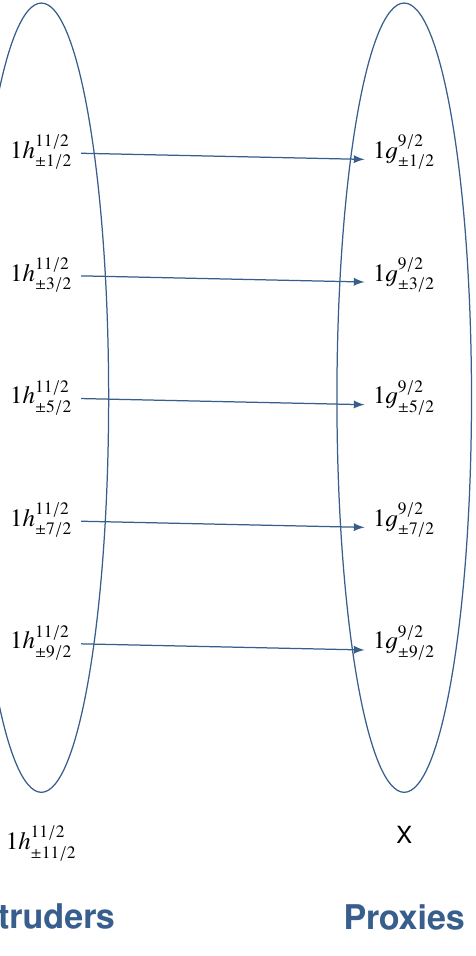
Figure 1. Unitary transformation of the intruder orbitals 1 h 11 / 2 m (except for the 1 h 11 / 2 ) in the 50-82 shell onto the orbitals 1 g 9 / 2 m ± 11 / 2 Adapted from Ref.